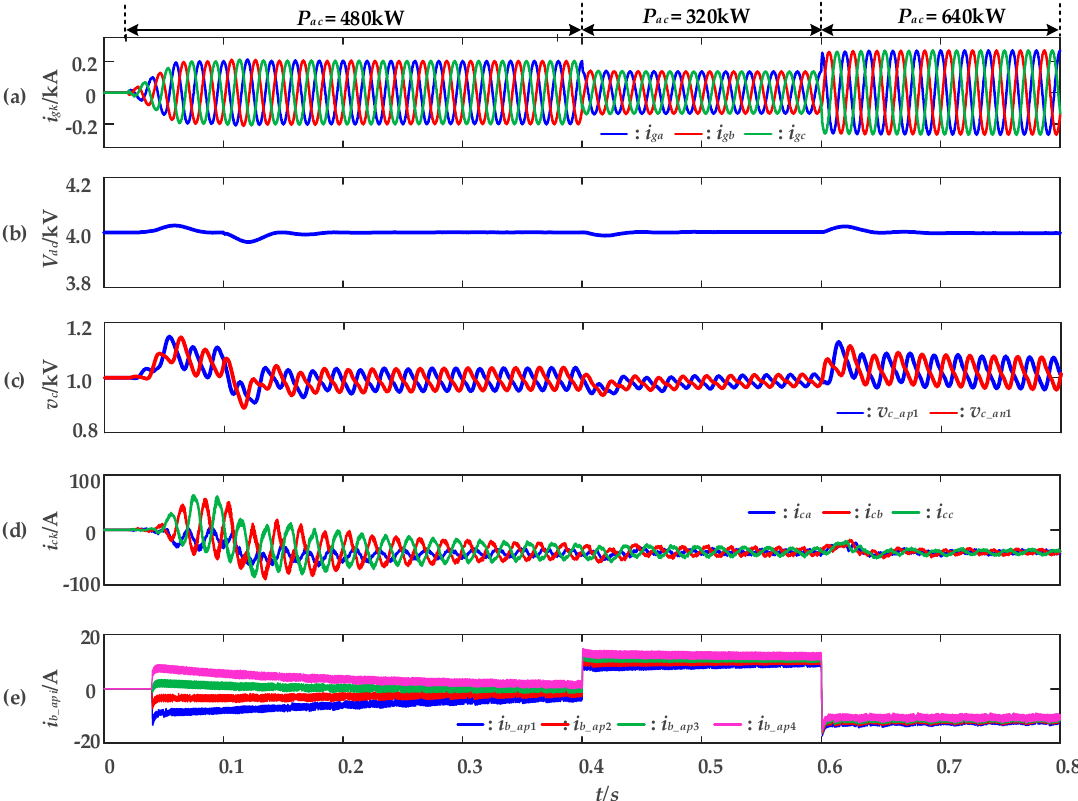
Figure 13. Simulation waveforms of rectifier mode operation of MMC-BESS. ( a ) Grid currents. ( b ) DC-link voltage. ( c ) Capacitor voltages of upper and lower arm of phase A. ( d ) Circulating currents. ( e ) Battery currents of SMs within upper arm of phase A.